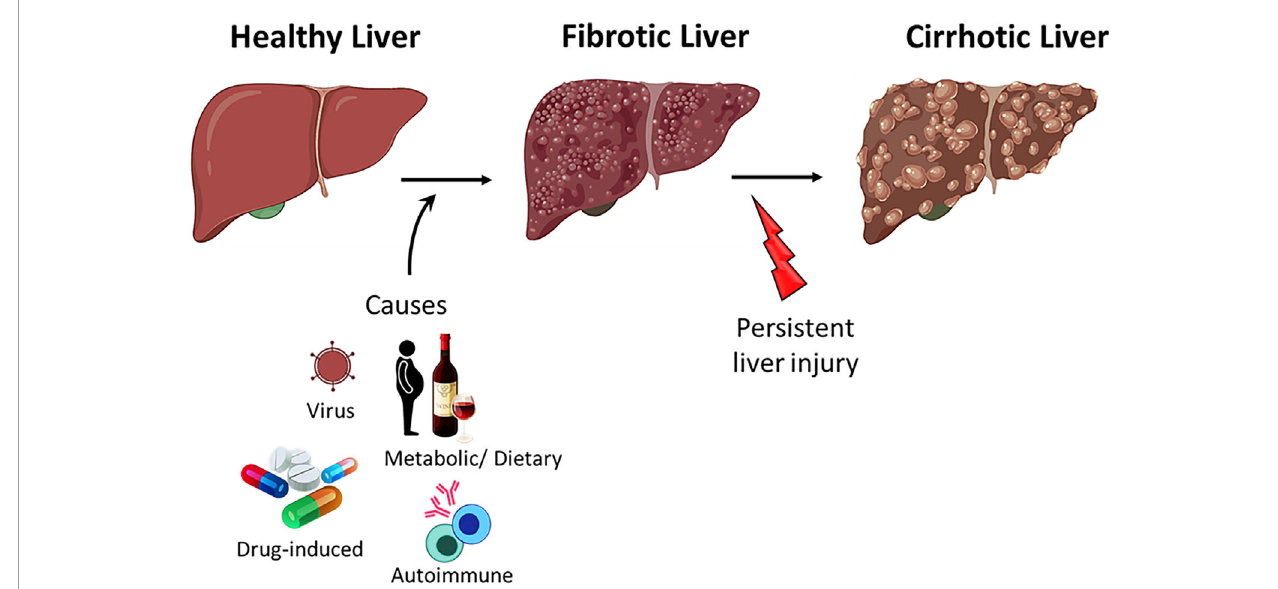
FIGURE 2 | Progression of liver disease. Healthy liver can regenerate after acute injury however, persistent injury to the liver results in hepatocyte damage, in fl ammation and fi brosis. Persistent insult to the fi brotic liver may progress to